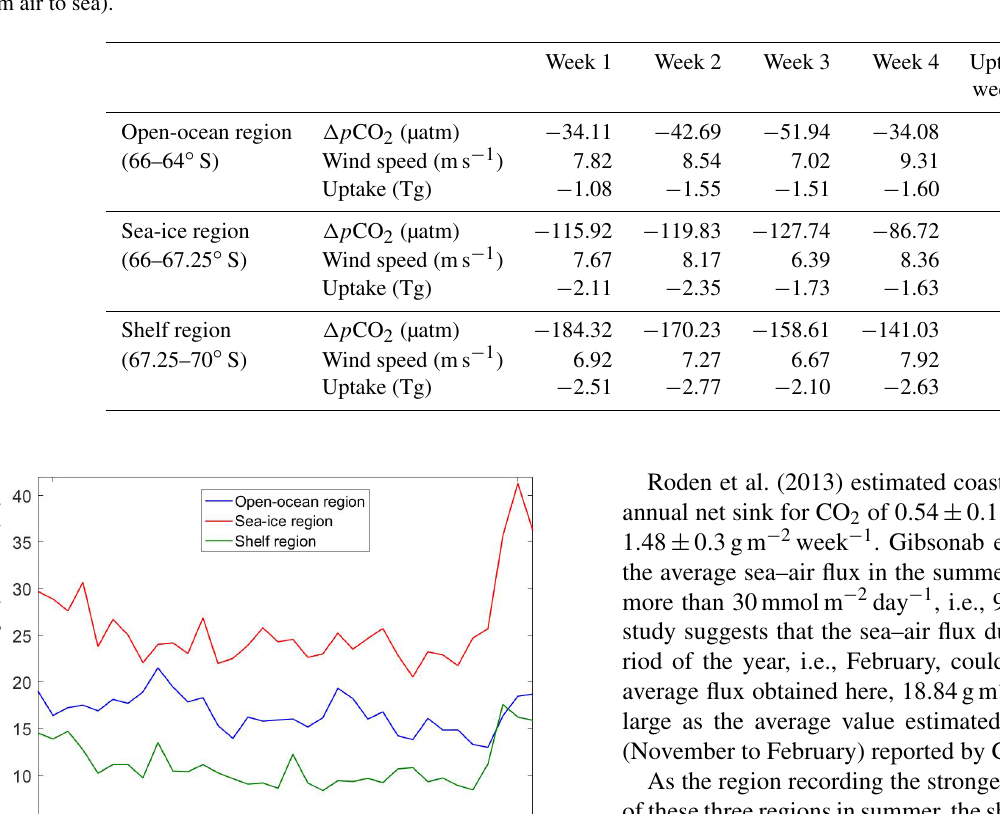
Table 3. Regional and weekly mean (cid:49)p CO 2 , wind speed and uptake of CO 2 in three subregions (negative values represent directions moving from air to sea).